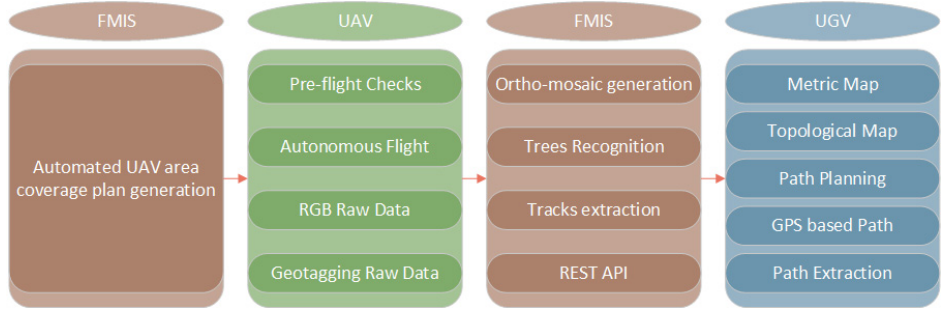
Figure 2. System’s